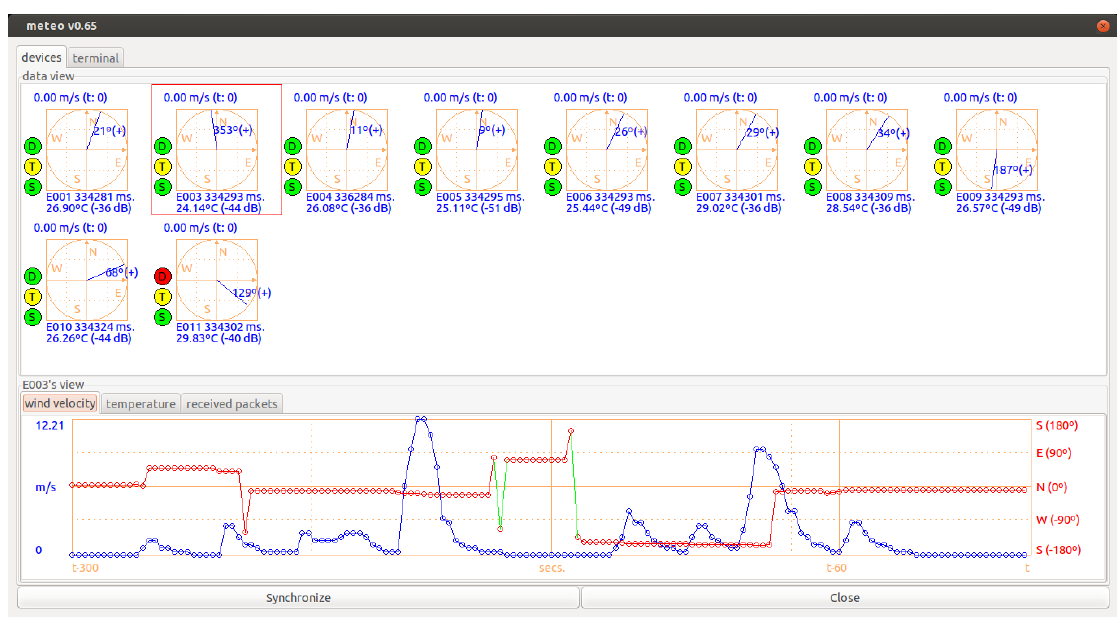
Figure 5. Base station. Control and monitoring interface. On the data view , each registered sensing device appears showing graphically the wind data the base station is receiving from it. By selecting a device in this view, we can see the last 5 min (300 s) of accumulated data below that specific device. The data view also provides for each device three “virtual” LED status indicators (coloured circles), namely: “S” for signal/communication status, “T” for temperature status and “D” for data reception